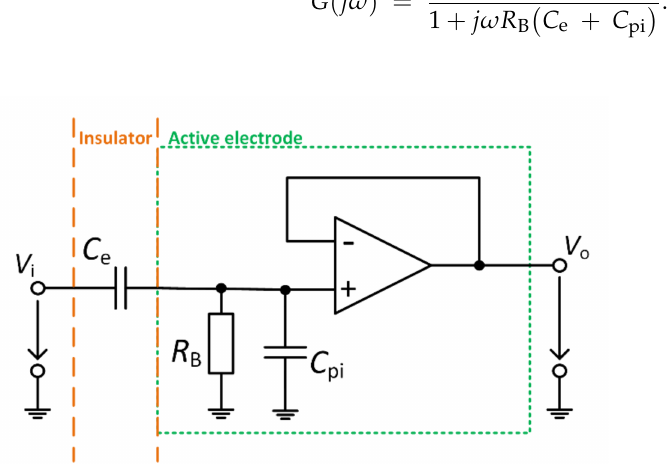
Figure 1. Model of the active